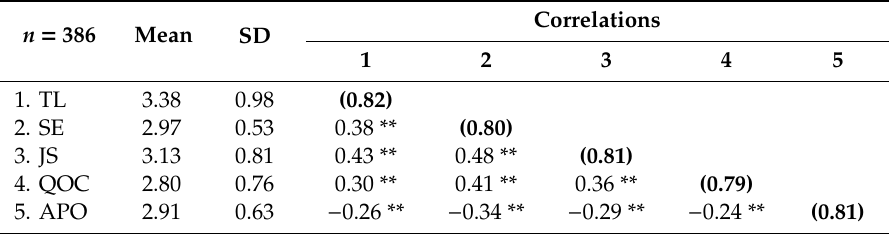
Table 2. Descriptive statistics and